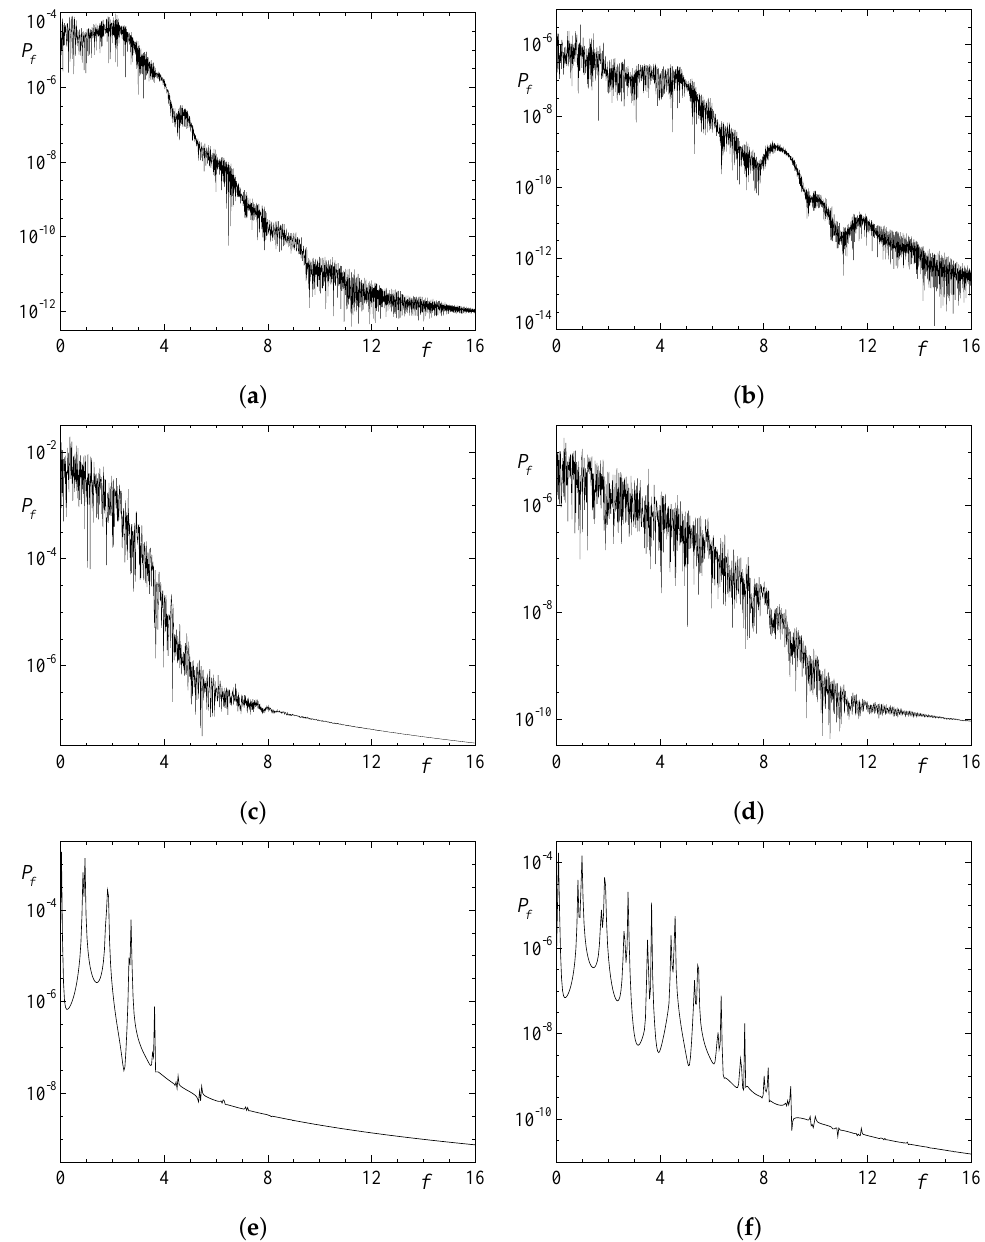
Figure 23. Temporal power spectra of the Fourier coefficients Re ˆ v 1 column) in the standard-resolution run 4 x 1.1 in the time intervals 15 ≤ t ≤ 120, (a), (b); 132 ≤ t ≤ 212, (c), (d); and 223 ≤ t ≤ 242, (e), (f). The isosurfaces of the kinetic and magnetic energy densities, shown in Figure 24, demonstrate that the quasiperiodic flow depends on all three spatial variables and does not acquire smaller spatial